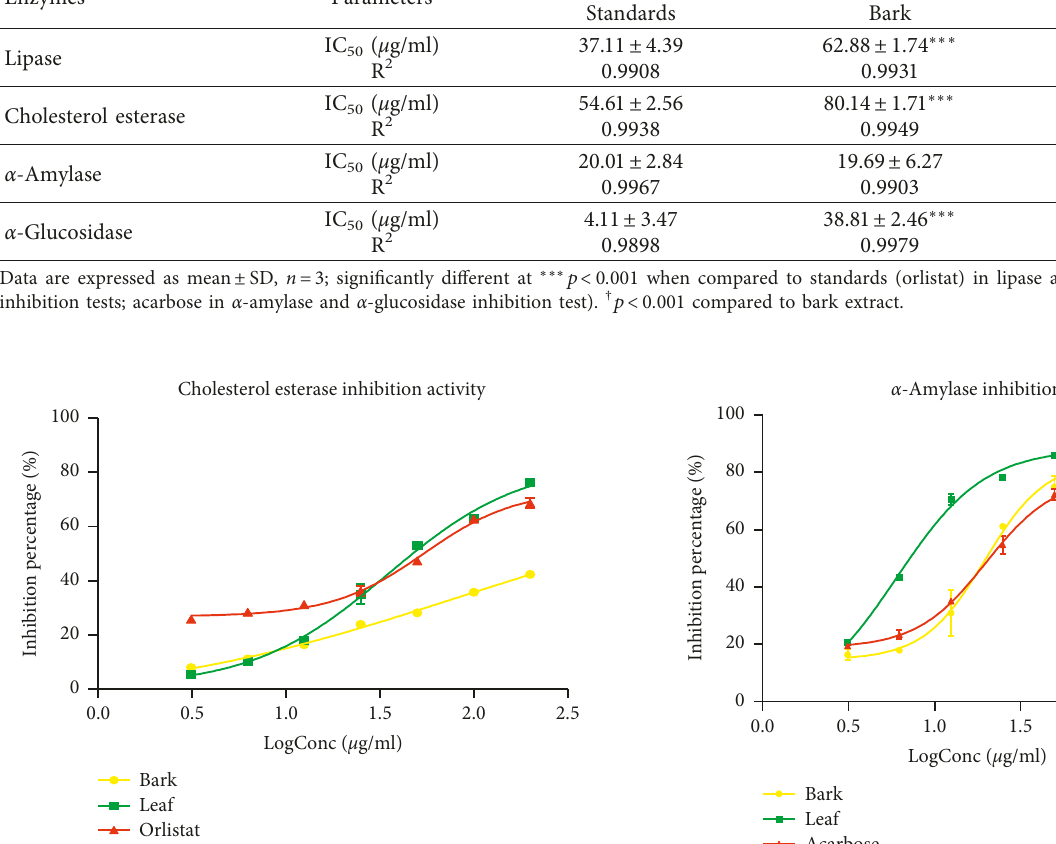
Table 5: IC 50 and correlation coefficient ( r ) of hydro-ethanolic leaf and bark extracts in lipase, cholesterol esterase, α -amylase, and α -glucosidase inhibition activity compared to standards. Enzymes